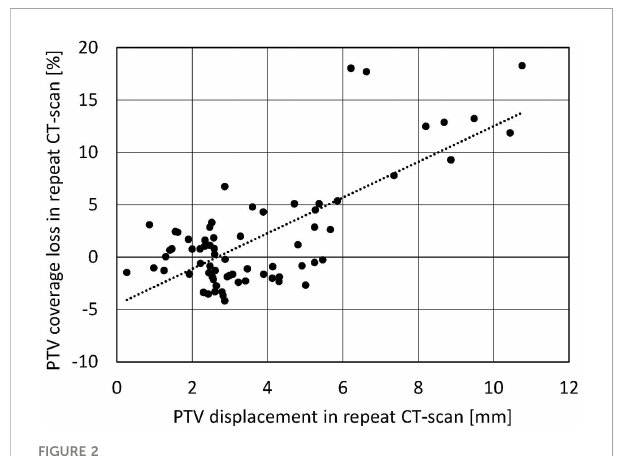
FIGURE 2 PTV coverage loss in repeat CT scans as a function of PTV displacement relative to fi ducials. Each data point refers to one of the repeat scans of one of the included patients (70 data points in total). The dotted line is a linear fi